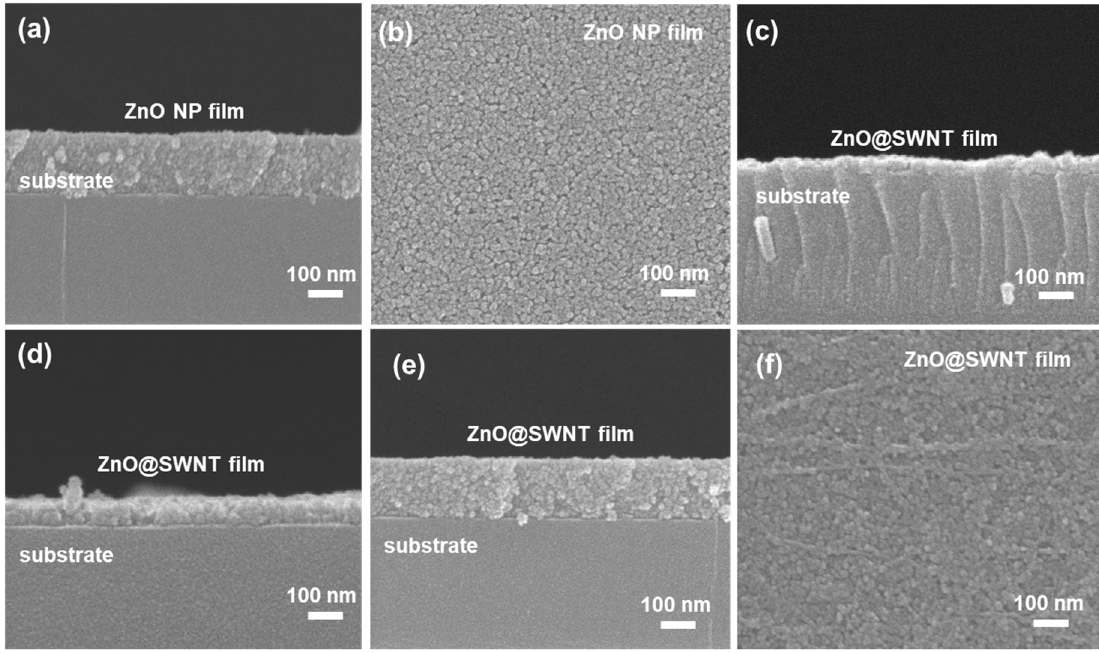
Figure 3. ( a ) Cross-sectional and ( b ) top-view SEM images of the ZnO NP film, ( c – e ) cross-sectional SEM images of ZnO@SWNT films spin-coated 1, 3, and 5 times, respectively, and ( f ) top-view of SEM image of the ZnO@SWNT film. The thickness of ZnO film (7 times of spin coating in Figure 3a) and ZnO@SWNT (5 times of spin coating in Figure 3e) were same as 165 nm.